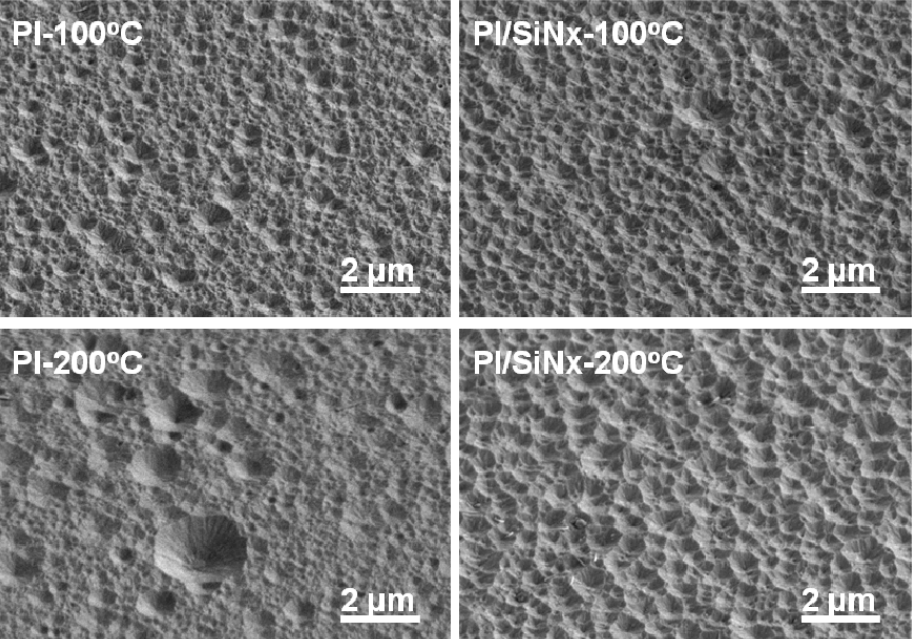
Figure 8. Surface morphologies of the etched GZO thin films deposited on different substrates as a function of deposition